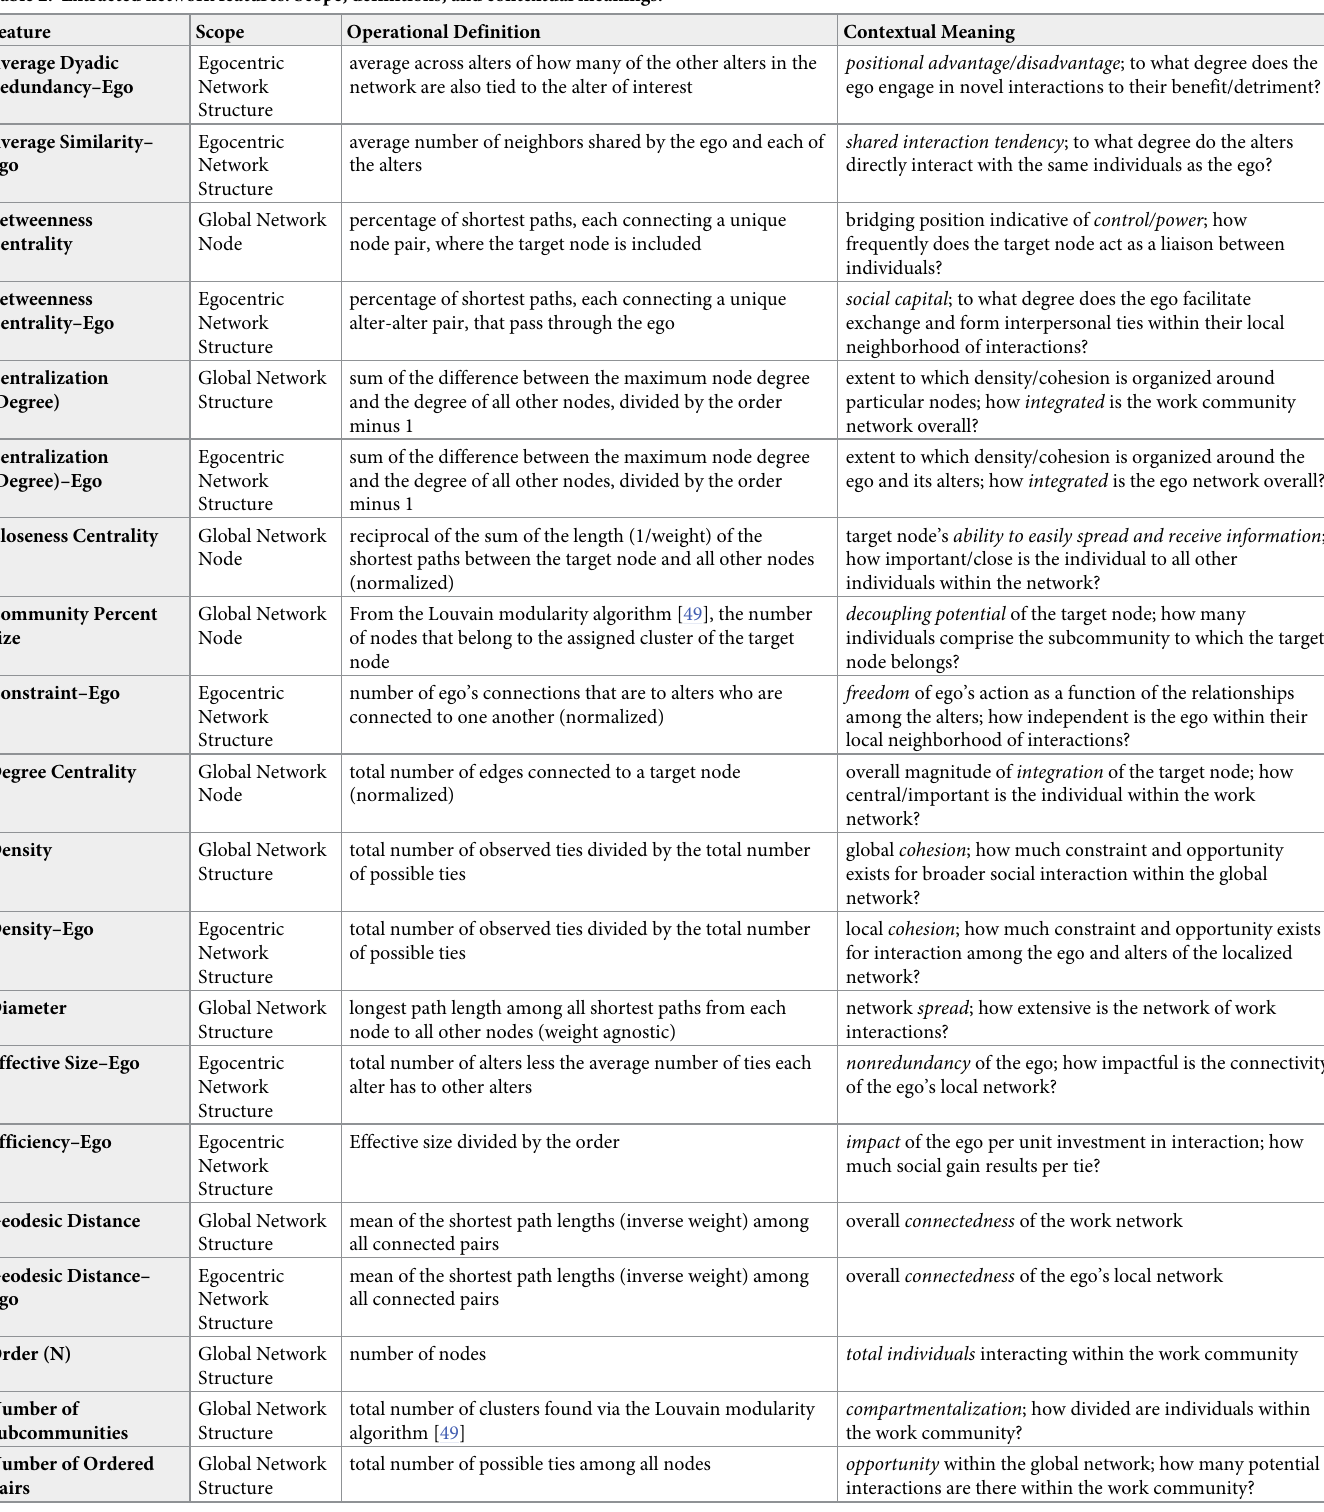
Table 2. Extracted network features: Scope, definitions, and contextual